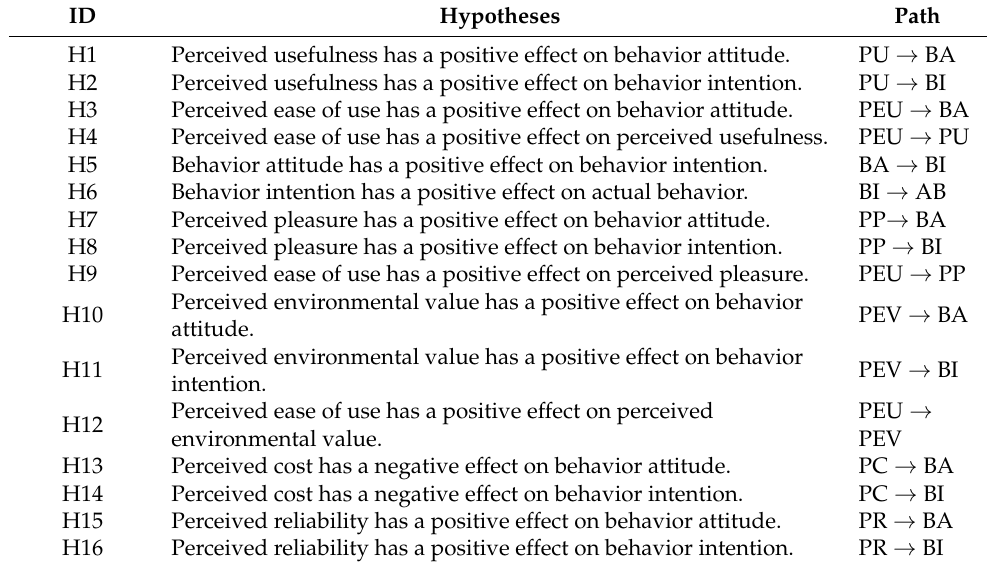
Table 1. Research hypotheses.